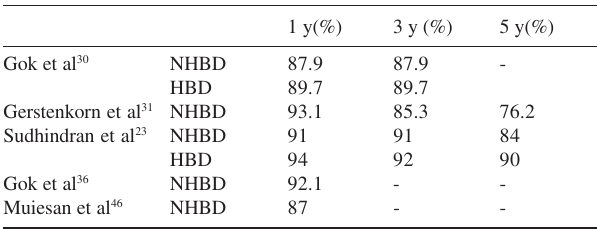
s-significant; ns- not statistically significant; nm- not mentioned; nhbd-non-heart-beating donor;hbd-heart-beating donor; pnf-primary non-function;dgf- delayed graft function;ar-acute rejection. Table 8 - Graft survival in NHBD in England. Table 9 - Patient survival in NHBD in